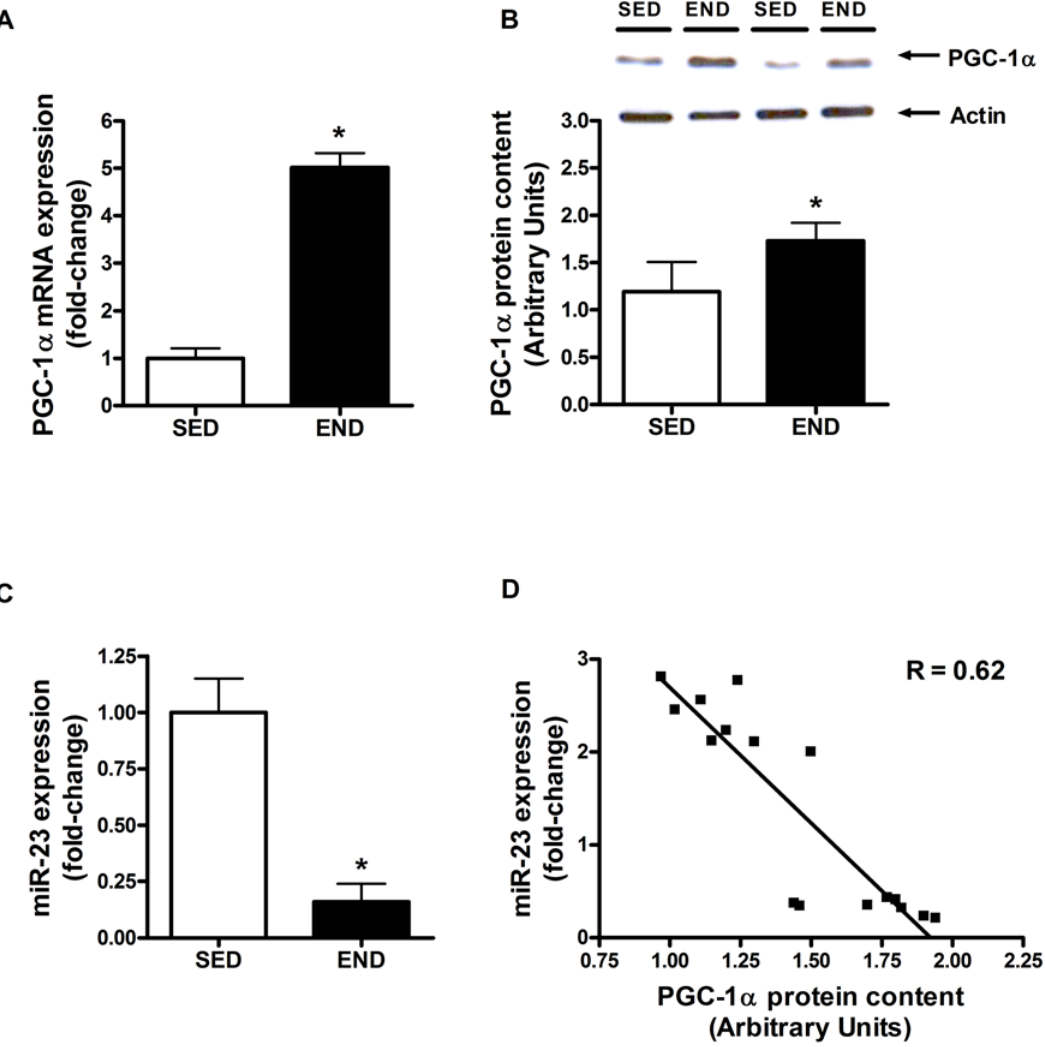
Figure 1. PGC-1 a content and miR-23 expression following exercise. PGC-1 a (A) mRNA expression and (B) protein content, and (C) miR-23 expression in the quadriceps of C57Bl/6J mice (N=7/group) 3-hour following an acute bout of END exercise vs. SED group. (D) PGC-1 a protein content negatively correlates (R=0.62) with miR-23 content. PGC-1 a mRNA expression, protein content and miR-23 expression are normalized to b -2 microglobulin, actin and Rnu6 , respectively. Asterisks denote significant changes (P # 0.05).